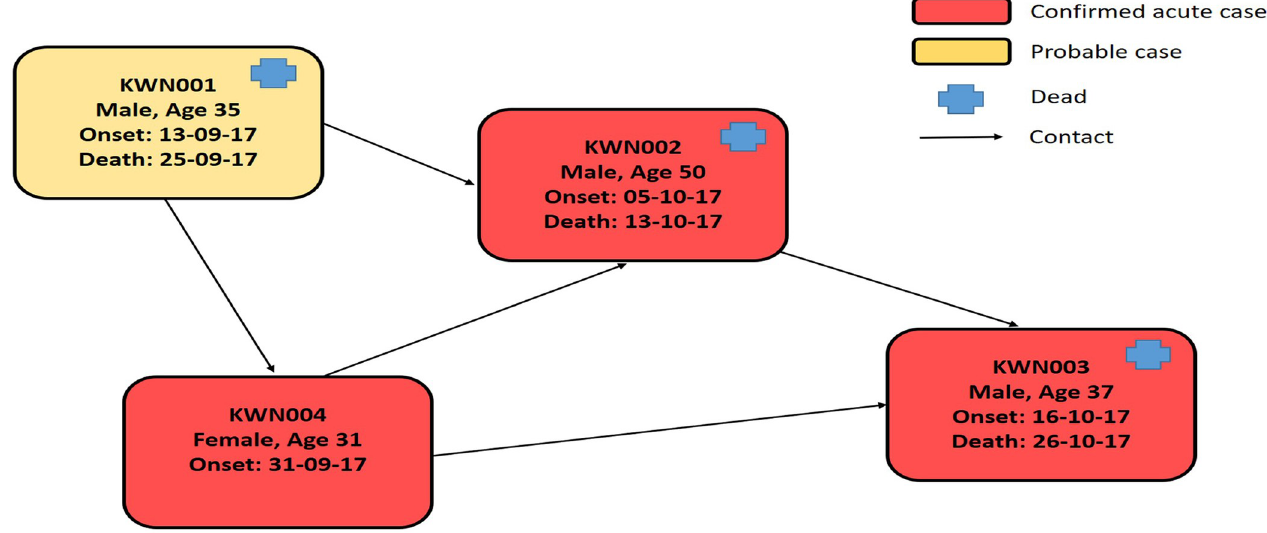
Fig 2. Transmission chain for MVD cases, Kween District,